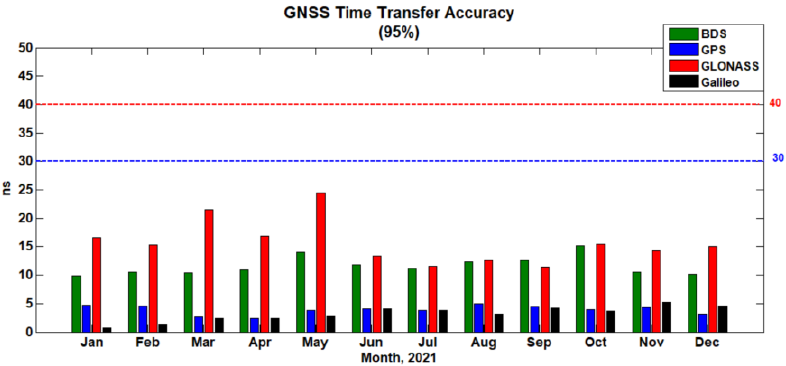
Figure 5. Histogram of monthly GNSS time transfer accuracy assessment results in